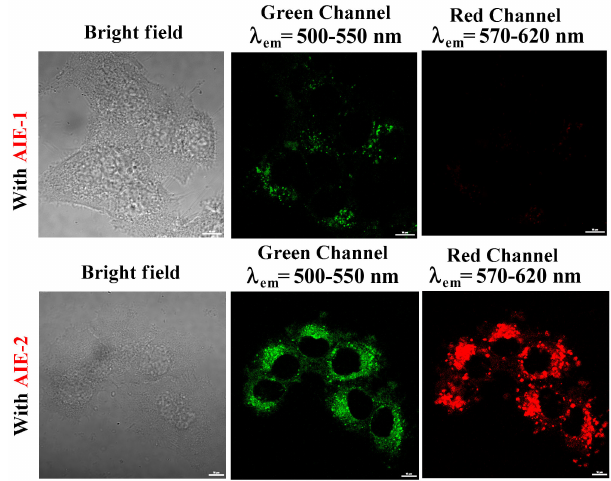
Figure 8. HeLa cell images in bright field, green channel ( λ em = 500–550 nm), and red channel ( λ em = 570–620 nm), incubated with 3 µ M solution of AIE-1 and AIE-2. The scale bars for all the images are 10 µ